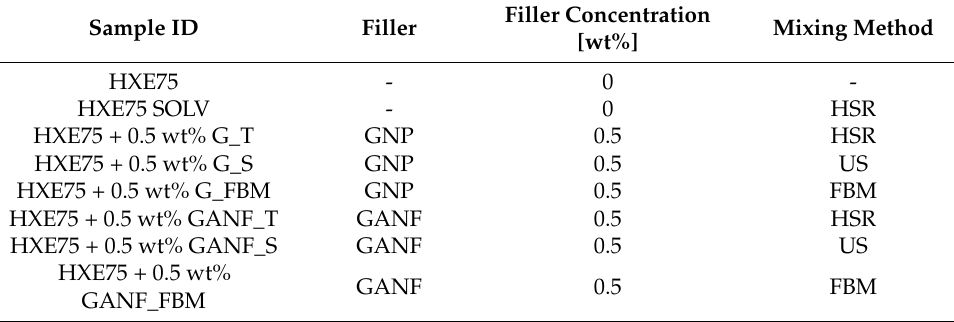
Table 1. List of the manufactured